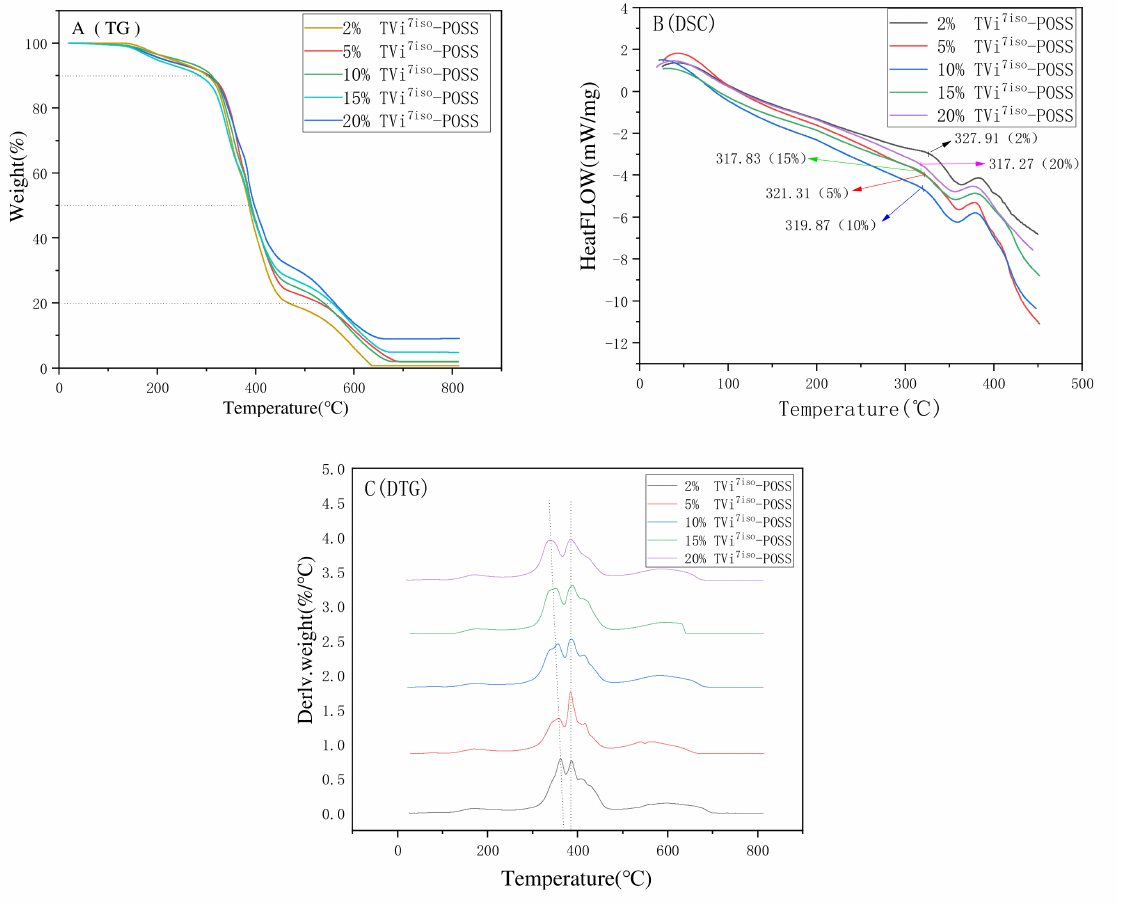
Figure 7. TGA, DSC, and DTG thermograms of the PFMPUA coatings with different TVi 7iso –POSS contents. ( A ) TGA thermograms; ( B ) DSC thermograms of the coating; ( C ) DTG